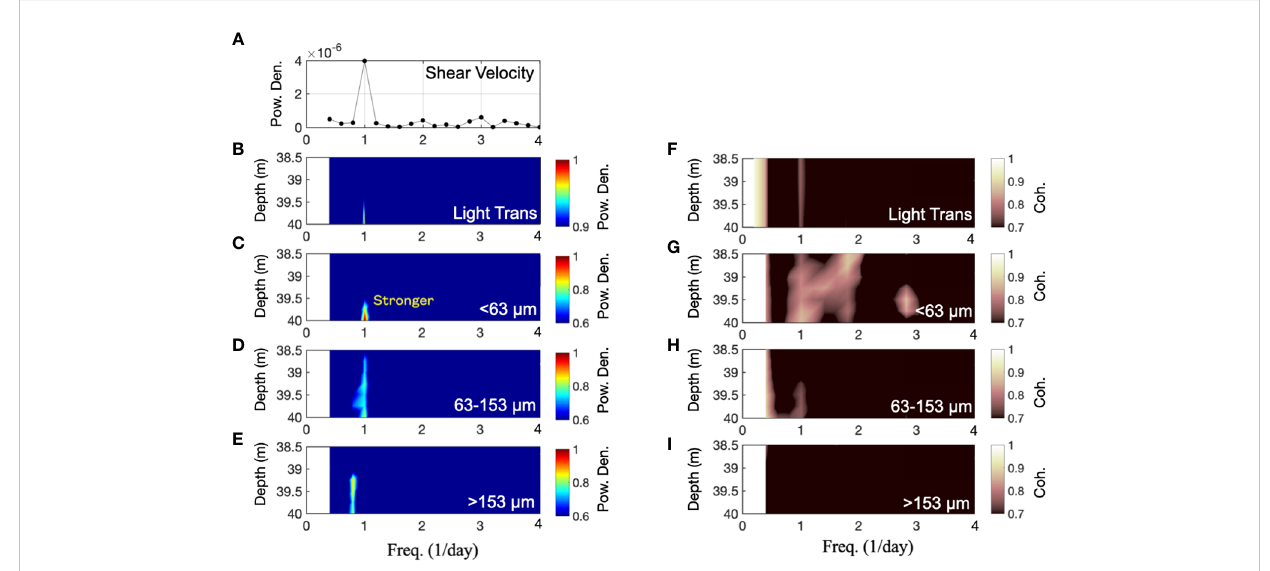
FIGURE 10 Power spectra and coherence plots of (A) the shear velocity (u *cw ); (B-E) light transmission, and VCs in<63, 63-153, and >153 µm grain size classes, respectively in the depth range of 38.5~40 m; (F-I) The coherence between the spectra of the light transmission and VCs in<63, 63-153, and >153 µm grain size classes, respectively in the depth range of 38.5~40